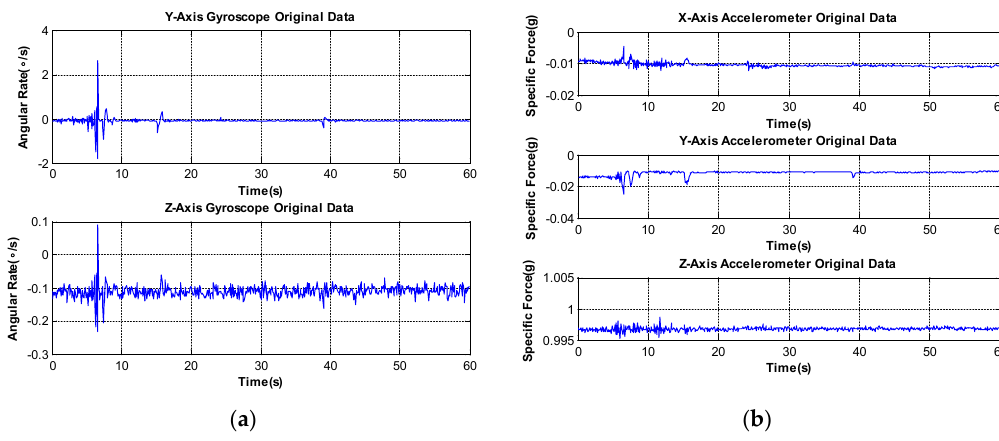
Figure 11. ( a ) Two-axes gyroscope original data; and ( b ) three-axes accelerometer original data.